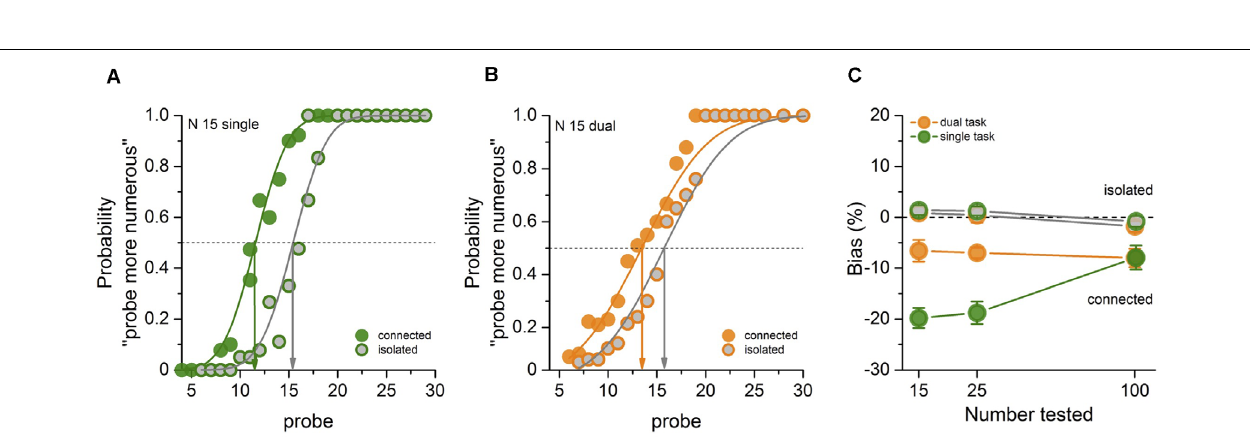
FIGURE 2 | Psychometric functions for a typical participant for the single- (A) and dual-task (B) attentional condition at N15. The graphs plot the proportion of trials where the probe appeared more numerous than the reference (15 dots), as a function of probe numerosity (shown on the abscissa). The vertical arrows show the estimates of the point of subjective equality (PSE), given by the median of the fitted cumulative Gaussian functions. Green and orange respectively refer to single- and dual-task conditions; gray fillings refer to baseline (isolated) conditions, otherwise connected conditions. (C) Average PSEs as a function of dot number expressed as the percentage difference from the reference number, color-coded as in (A,B) , for both connected and isolated conditions in single- and dual-task.